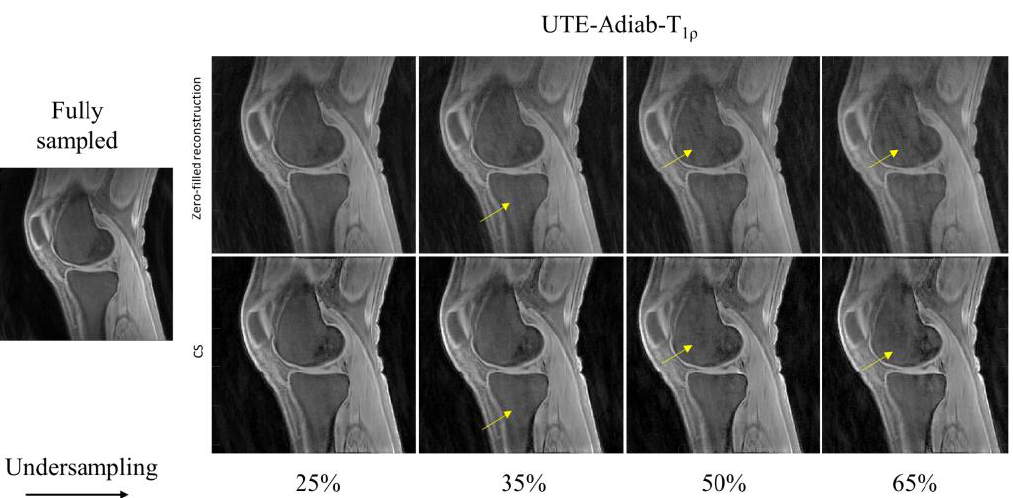
Figure 3. Comparison of UTE-Adiab-T 1ρ -reconstructed images at different undersampling rates between zero-filled reconstruction ( top row ) and CS-based reconstruction ( bottom row ). Image reconstructed using entire k-space data is shown as the reference. Reconstructed images using incomplete (i.e., undersampled) k-space via zero-filling carries streaking artifacts that are resolved using CS-based reconstruction, as marked by the yellow arrows.